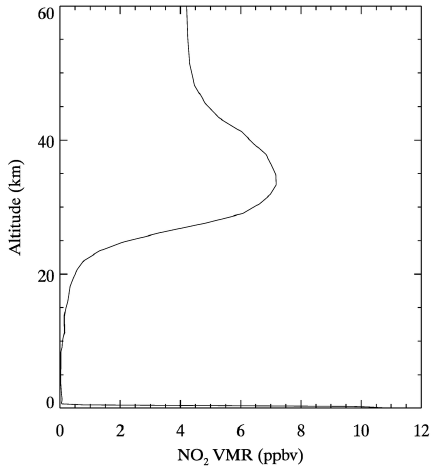
Figure 8. A typical box air mass factor calculated by the SCIA- TRAN RTM for a rural ground pixel. The red line indicates the instrument altitude (0.9km) at the time of the measurement.